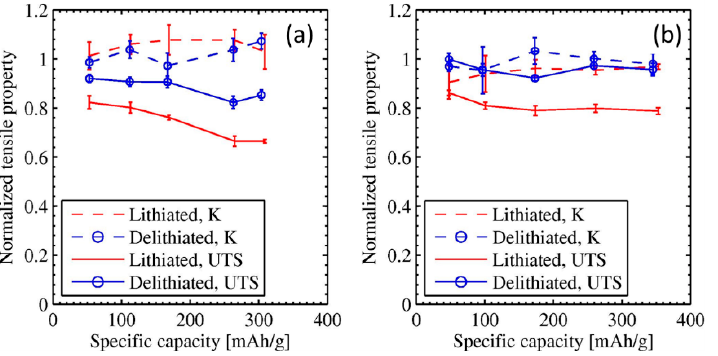
Figure 8. Mechanical properties and specific capacity of ( a ) IMS65, ( b ) T800H carbon fibers